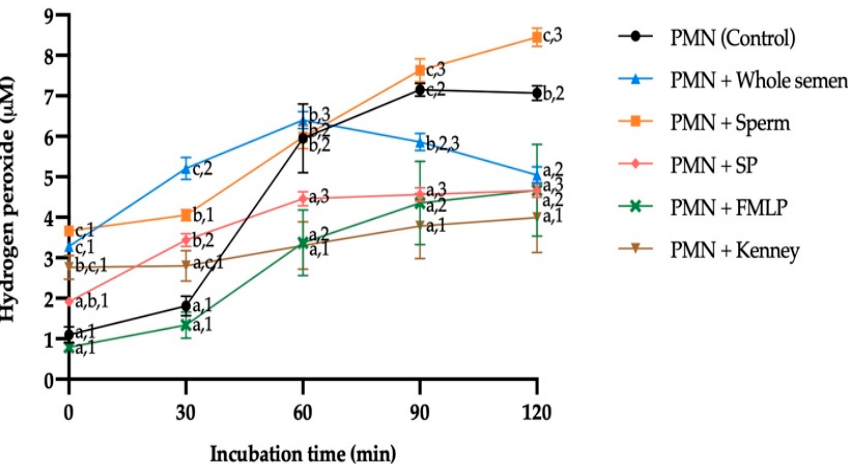
Figure 7. Mean ± SEM of extracellular H 2 O 2 production of jenny polymorphonuclear neutrophils (PMN) exposed to different treatments. (a–c) Different letters indicate significant differences ( p ≤ 0.05) between treatments within a given incubation time. (1–3) Different numbers indicate significant differences ( p ≤ 0.05) between incubation times within a given treatment.